Question: Name the type of graph shown.
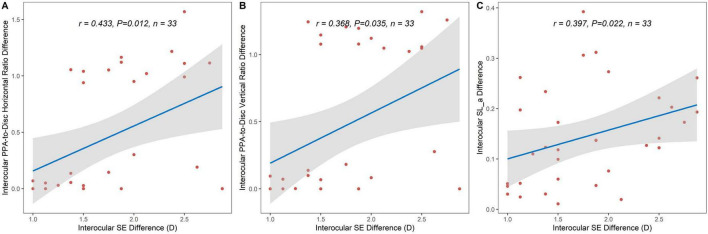
Answer: scatter